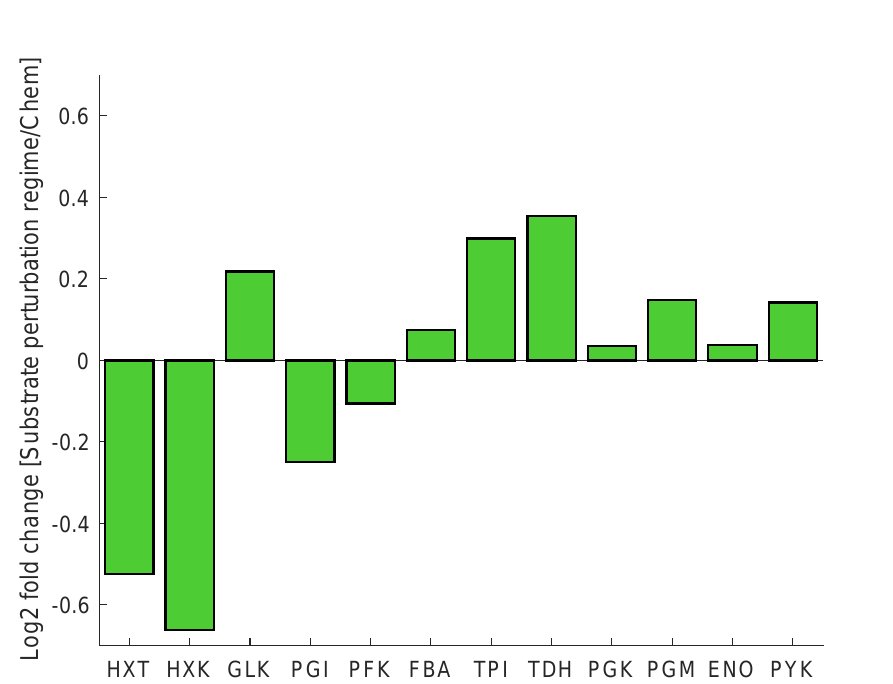
Figure 2. The protein concentration is presented as a log2 fold change from chemostat to dynamic substrate conditions of selected glycolytic and transporter proteins. Protein concentration fold change was measured by liquid chromatography tandem mass spectrometry